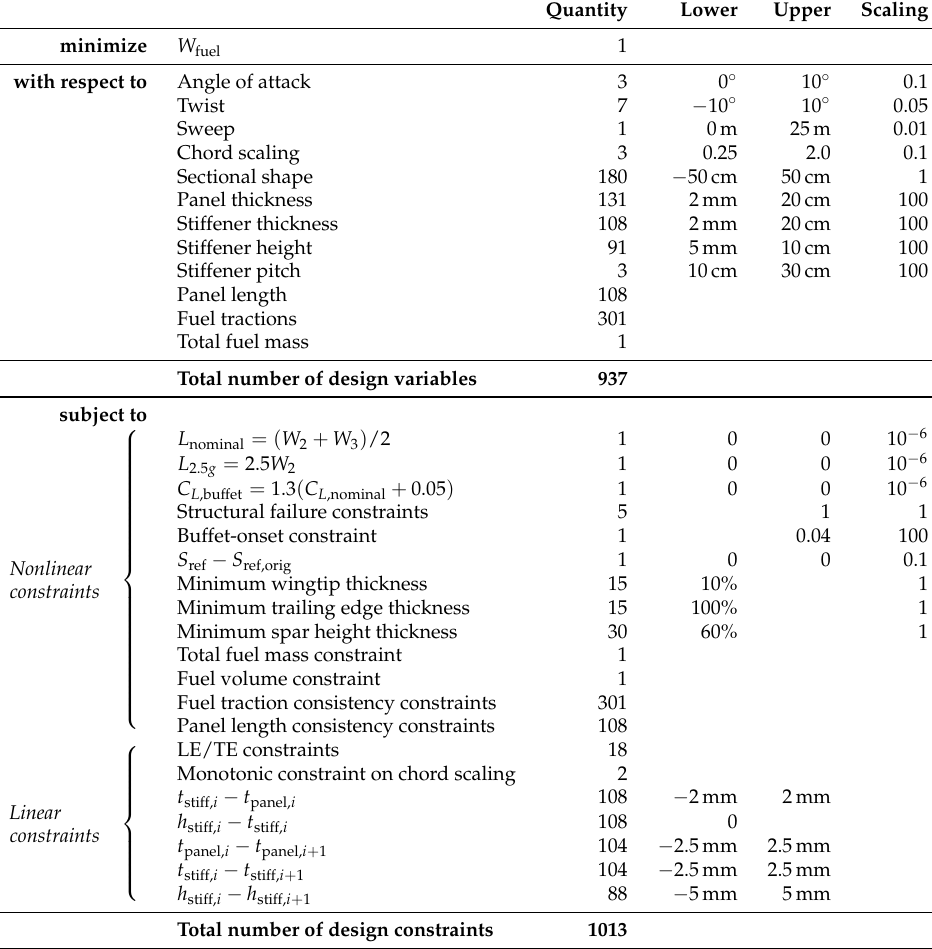
Table 4. Rectangular wing aerostructural optimization problem description.